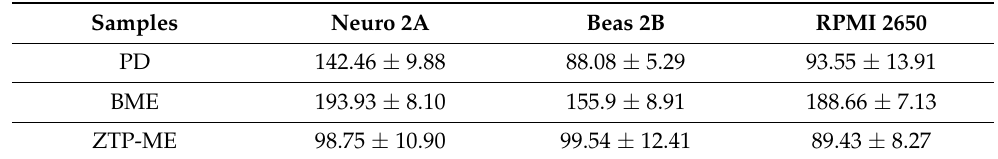
Table 3. IC 50 values of plain drug and formulations on various cell lines. PD = plain drug, BME = blank microemulsion, ZTP-ME = zotepine